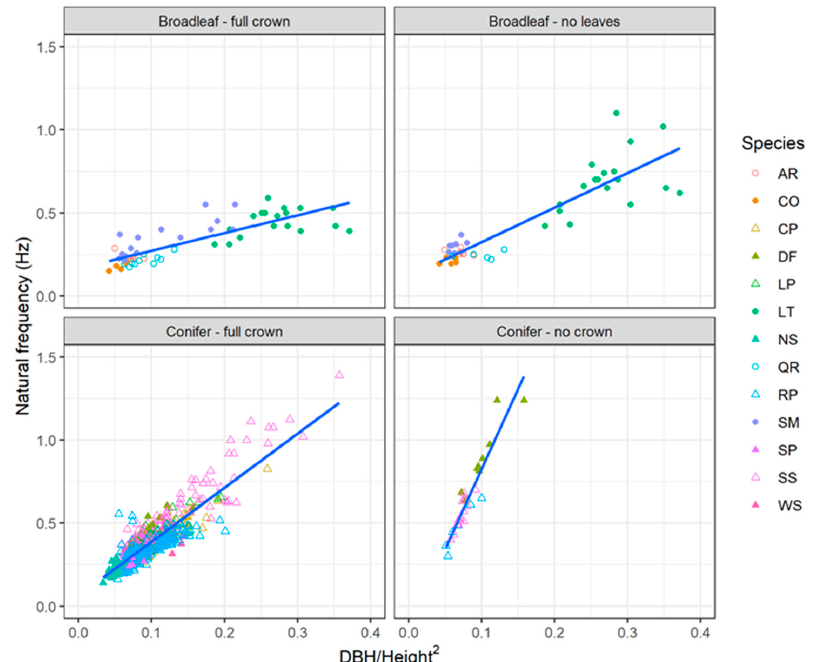
Figure 10. Relationship between natural frequency and the ratio of diameter at breast height (DBH) to total tree height squared for selected trees from the published literature.